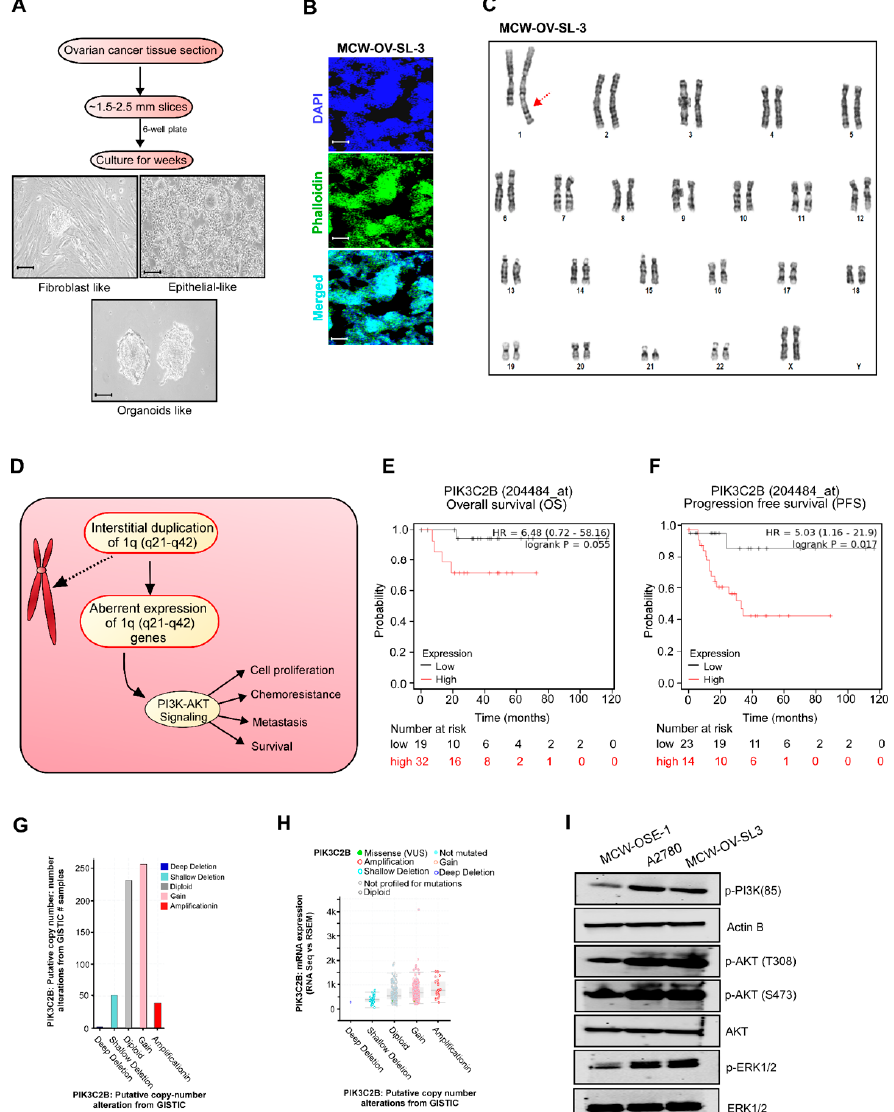
Figure 1. Establishment and characterization of the MCW-OV-SL3 cell line. ( A ) Workflow demonstrates the establishment of MCW-OV-SL-3 cell lines from endometroid ovarian cancer tissue. Isolated tissue sections were cut into small ~1.5–2.5 mm slices, then cultured in DMEM medium for 4 weeks until small organoids were formed. Fibroblasts were eliminated by differential trypsinization method until immortalized MCW-OV-SL-3 were grown continuously. Scale bars represent 500 µ m ( B ) MCW-OV-SL3 cells were immune stained using nucleus stain DAPI (Blue) and Phalloidin (green) for F-actin and photographed using a fluorescent microscope. Scale bars represent 500 µ m ( C ) Representative karyogram of MCW-OV-SL3 cell lines. Red arrow indicates duplication in the 1q locus (q21–q41). ( D ) A schema proposes how PIK3C2B duplication at the 1q locus (q21–q41) causes aberrant PI3K-AKT signaling. ( E , F ) Overall survival and progression free survival analysis in endometroid ovarian cancer. Patient samples that were stratified as high versus low based on median expression of PIK3C2B expression using KM survival analysis plotter. ( G ) Copy number variation (CNV) analysis was performed based on the copy number of PIK3C2B in ovarian cancer patients using GISTIC software from TCGA datasets. ( H ) mRNA expression analysis of PIK3C2B was performed based on the RNA seq data in ovarian cancer patients using GISTIC software from TCGA datasets. ( I ) Cell lysates were prepared from MCW-OSE-1, A2780, and MCW-OV-SL-3 monolayer cells and immunoblot was performed with indicated antibodies (see Figure